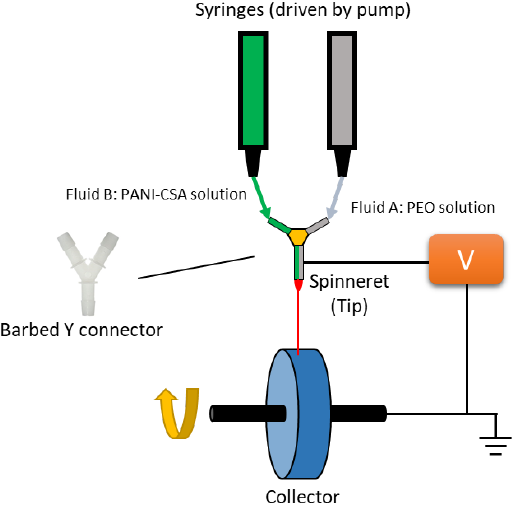
Figure 1. Schematic illusion of side-by-side electrospinning. PANI-CSA: Camphoric acid doped Polyaniline; PEO: polyethylene oxide.